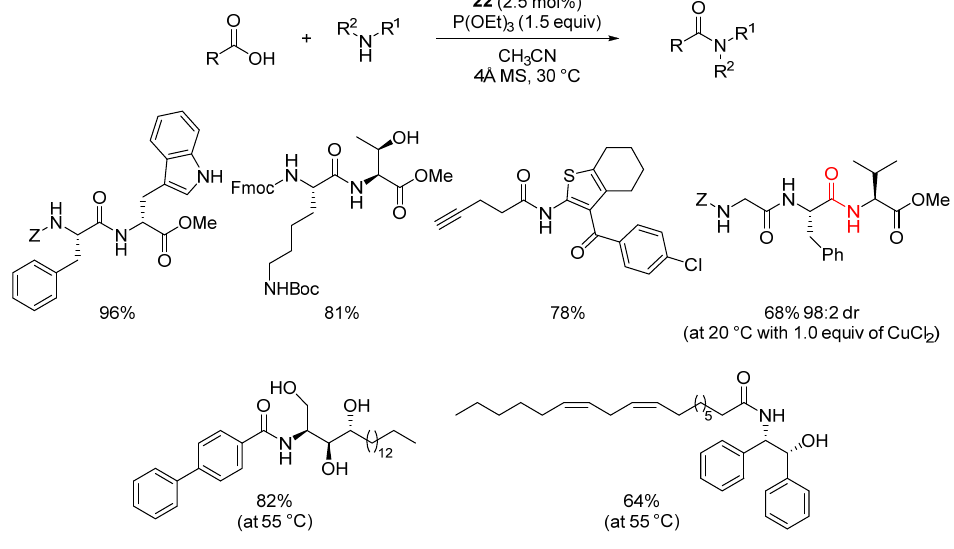
Scheme 18. Organocatalyzed 22 amidation